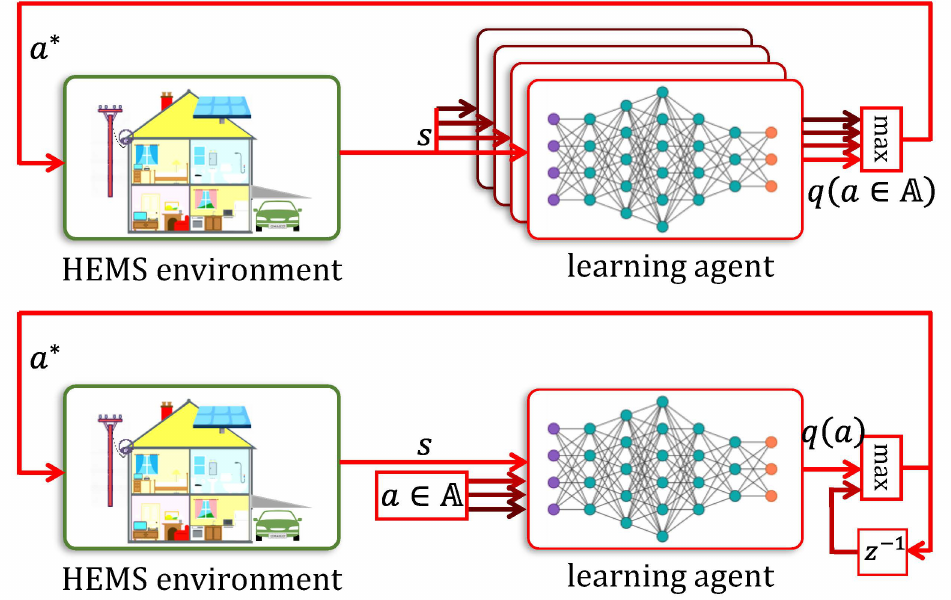
Figure 3. Deep Q-Network Layouts. One scheme uses a uses a separate DNN for each action ( top ). The other scheme uses only one DNN that receives actions as another input ( bottom